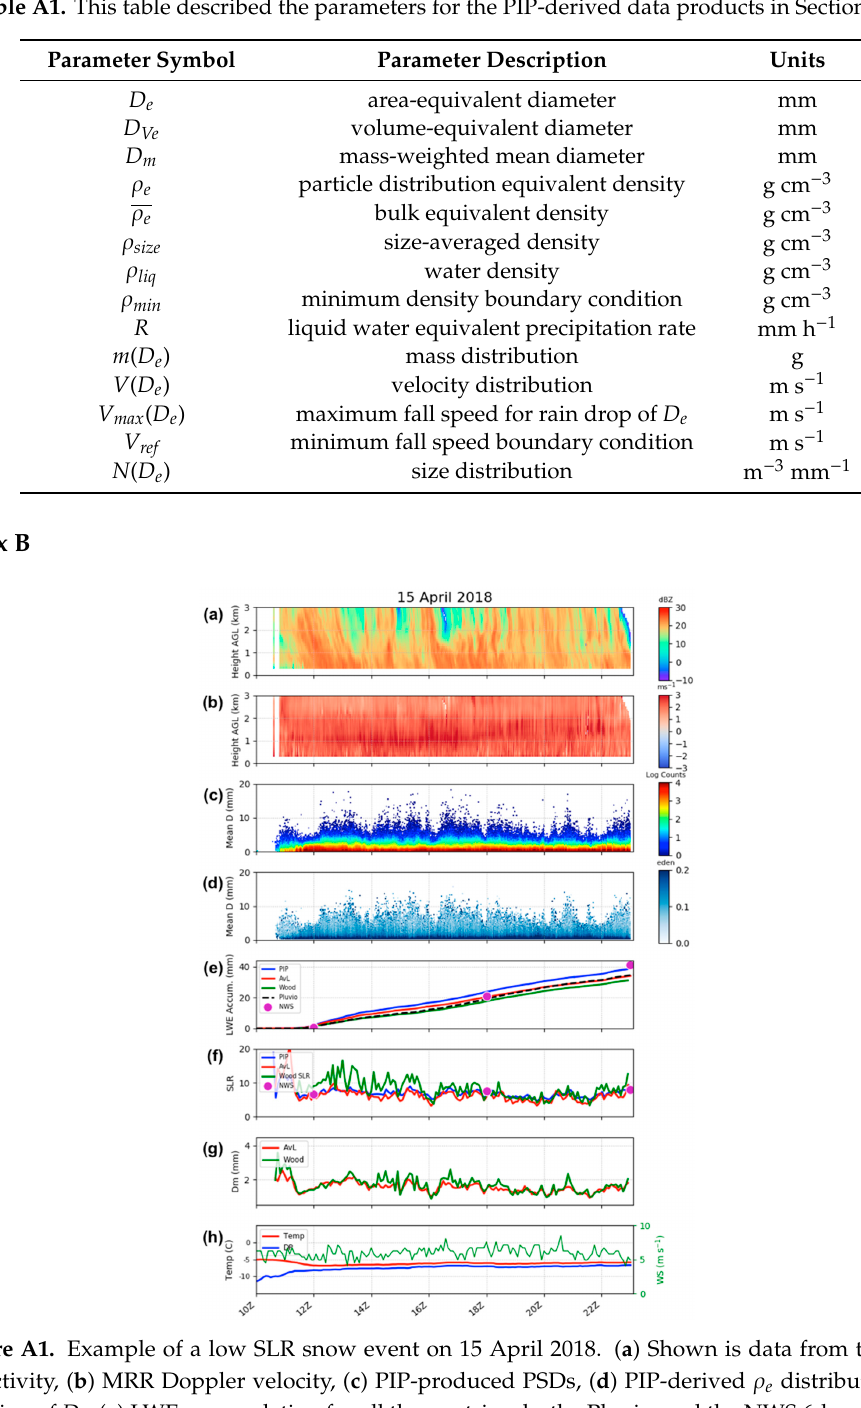
Table A1. This table described the parameters for the PIP-derived data products in Section 2.2.1.